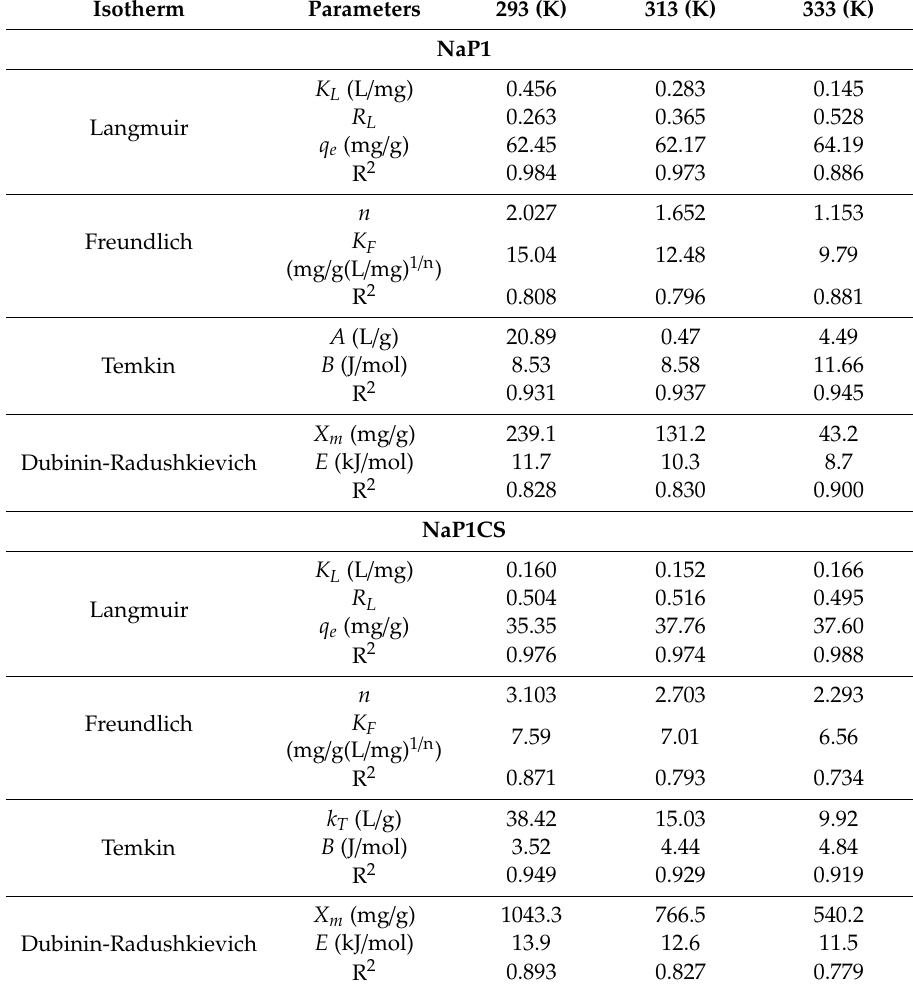
Table 3. Comparison of estimated parameters obtained from the Langmuir, Freundlich, Temkin,